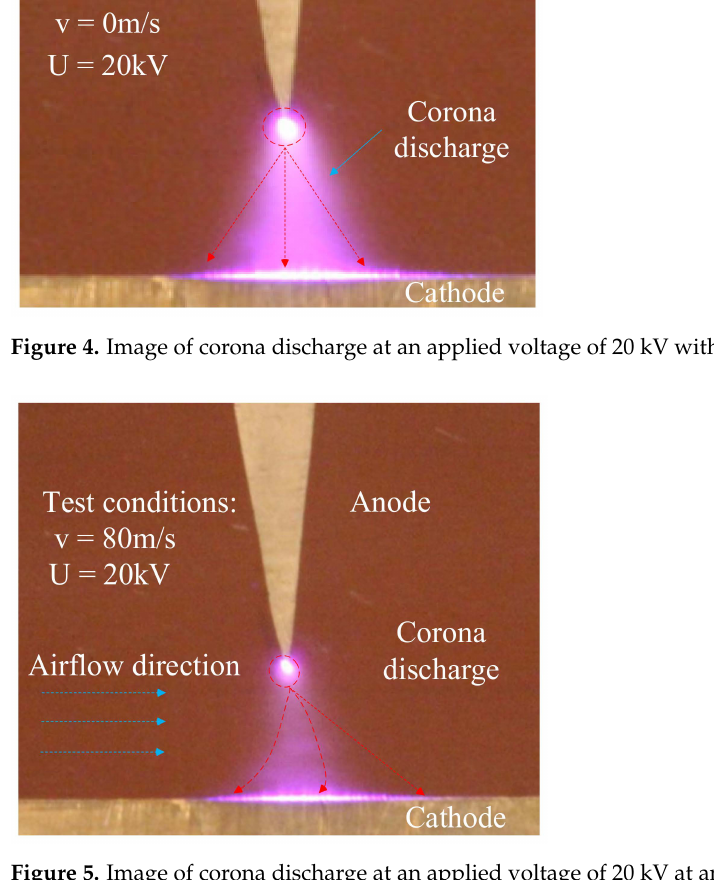
Figure 5. Image of corona discharge at an applied voltage of 20 kV at an airflow speed of 80